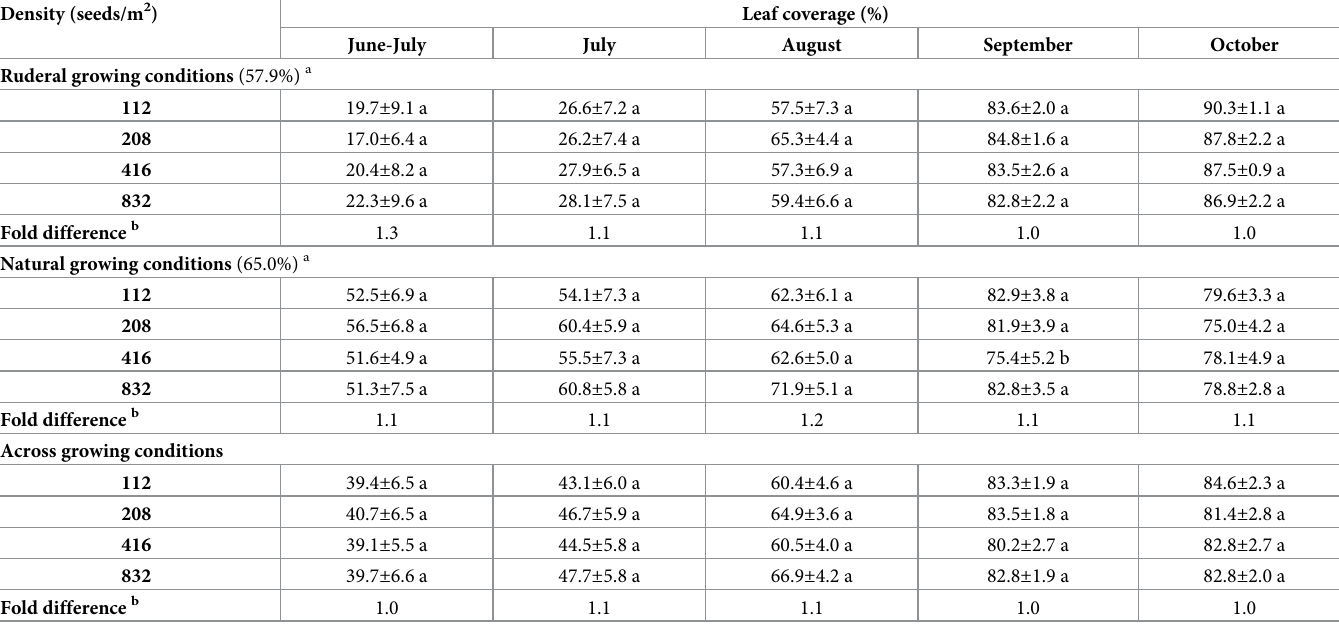
For each growing condition and leaf coverage observation, significant differences at 0.05 level among plant densities are designated by different letters. a Mean leaf coverage values of other plant vegetation during the season. b Fold difference between minimum and maximum values observed for different planting densities.